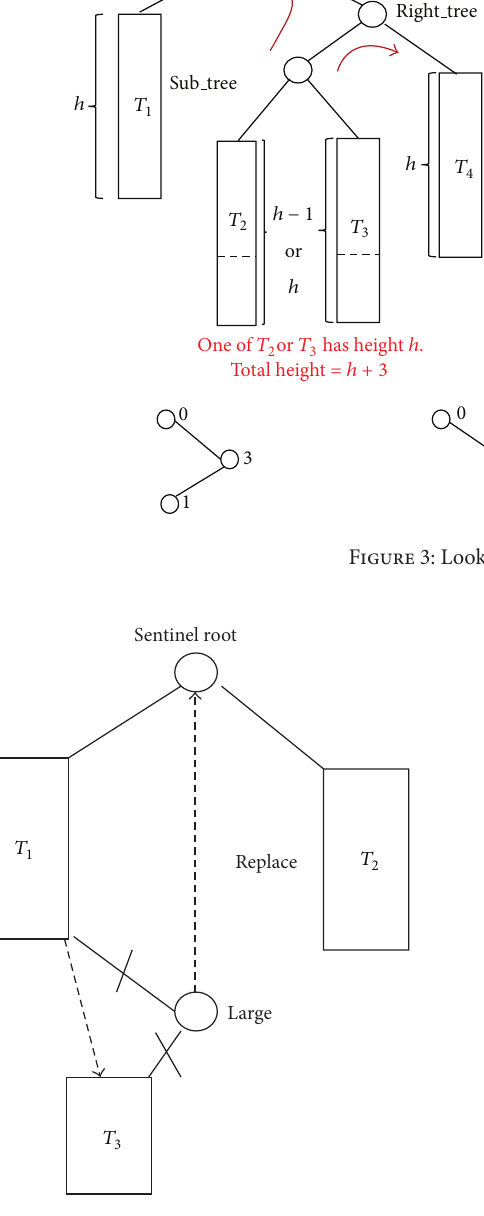
Figure 4: Removal of sentinel root